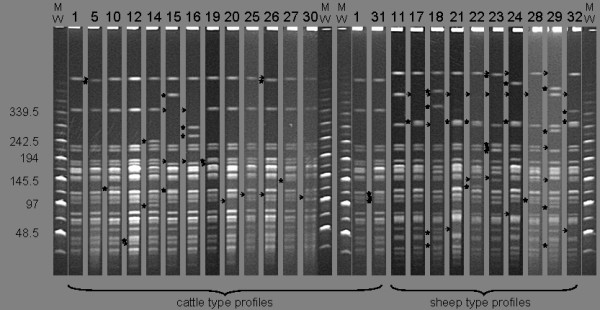
SpeI restriction profiles. Photographs of two gels comprising the 24 different SpeI pulsotypes detected. Numbers above the lanes correspond to the PFGE nomenclature. Arrows and asterisks indicate differences (band loss and new band, respectively) between type 1 and cattle type profiles, and between type 11 and sheep type profiles. MW = molecular weight standards, in Kilobases (Kb).